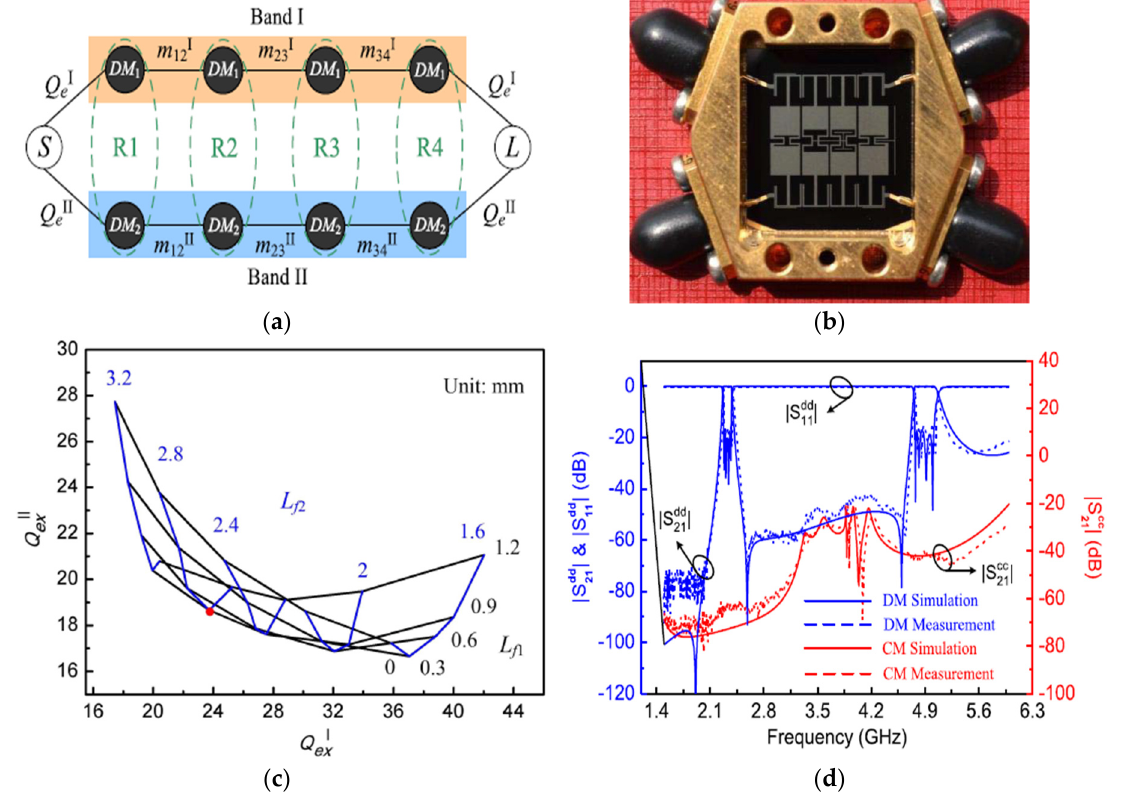
Figure 9. The proposed balanced four-pole dual-band BPF [62]: ( a ) Coupling scheme; ( b ) Photograph of the fabricated prototype; ( c ) Simulated external quality factors; ( d ) Simulated and measured frequency responses.